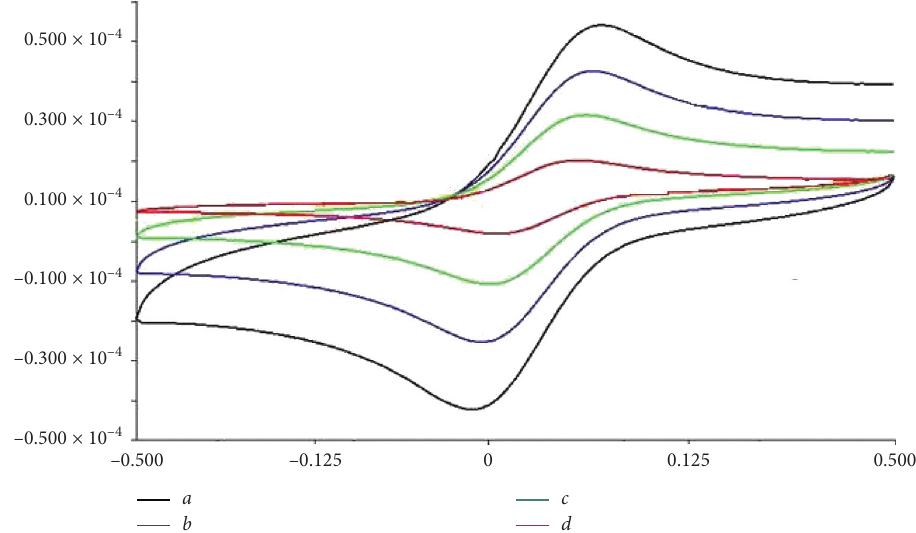
Figure 3: The CV voltammograms of the 0.3M probe solution at the surface (a) unloaded MIP/GO-Fe Fe 3 O 4 @SiO 2 /Pt, (c) loaded MIP/Pt, and (d) loaded MIP/GO-Fe 3 O 4 @SiO 2 /Pt.